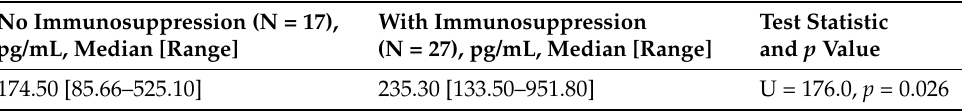
Table 4. Salusin- α concentrations in the experimental group—patients treated with either vasodilators only or with vasodilators in combination with immunosuppressive